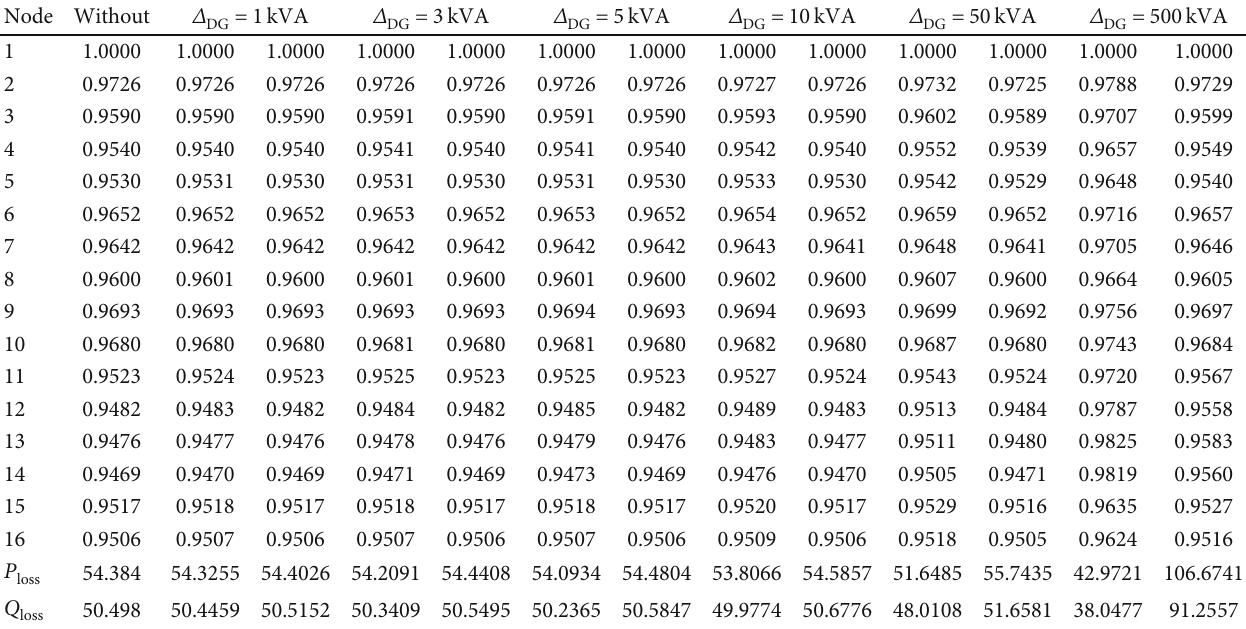
Table 3: Simulation